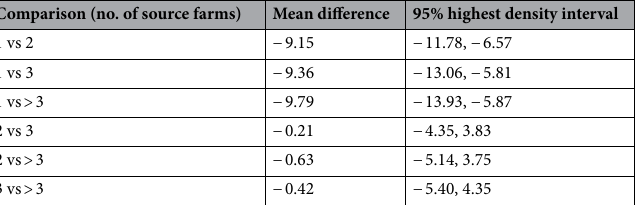
Comparison (no. of source farms)